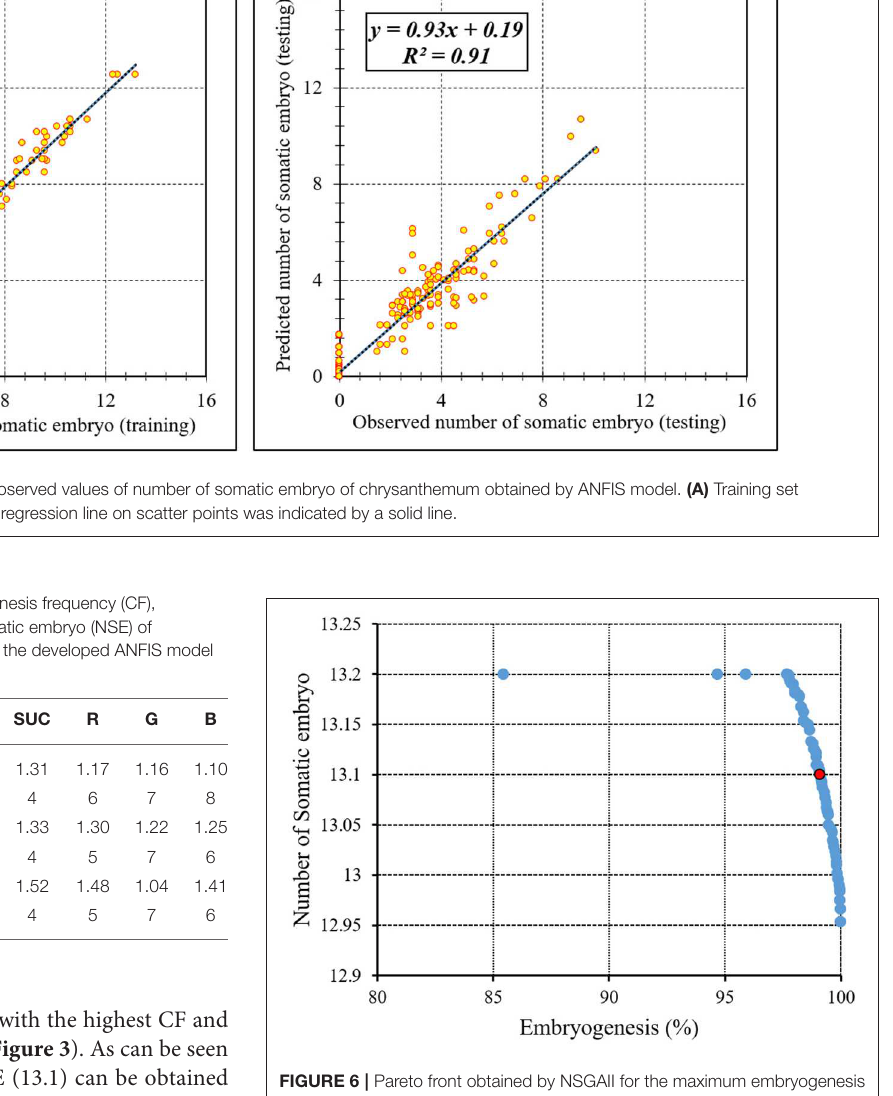
FIGURE 6 | Pareto front obtained by NSGAII for the maximum embryogenesis frequency and number of somatic embryo of chrysanthemum. The red point indicates the ideal